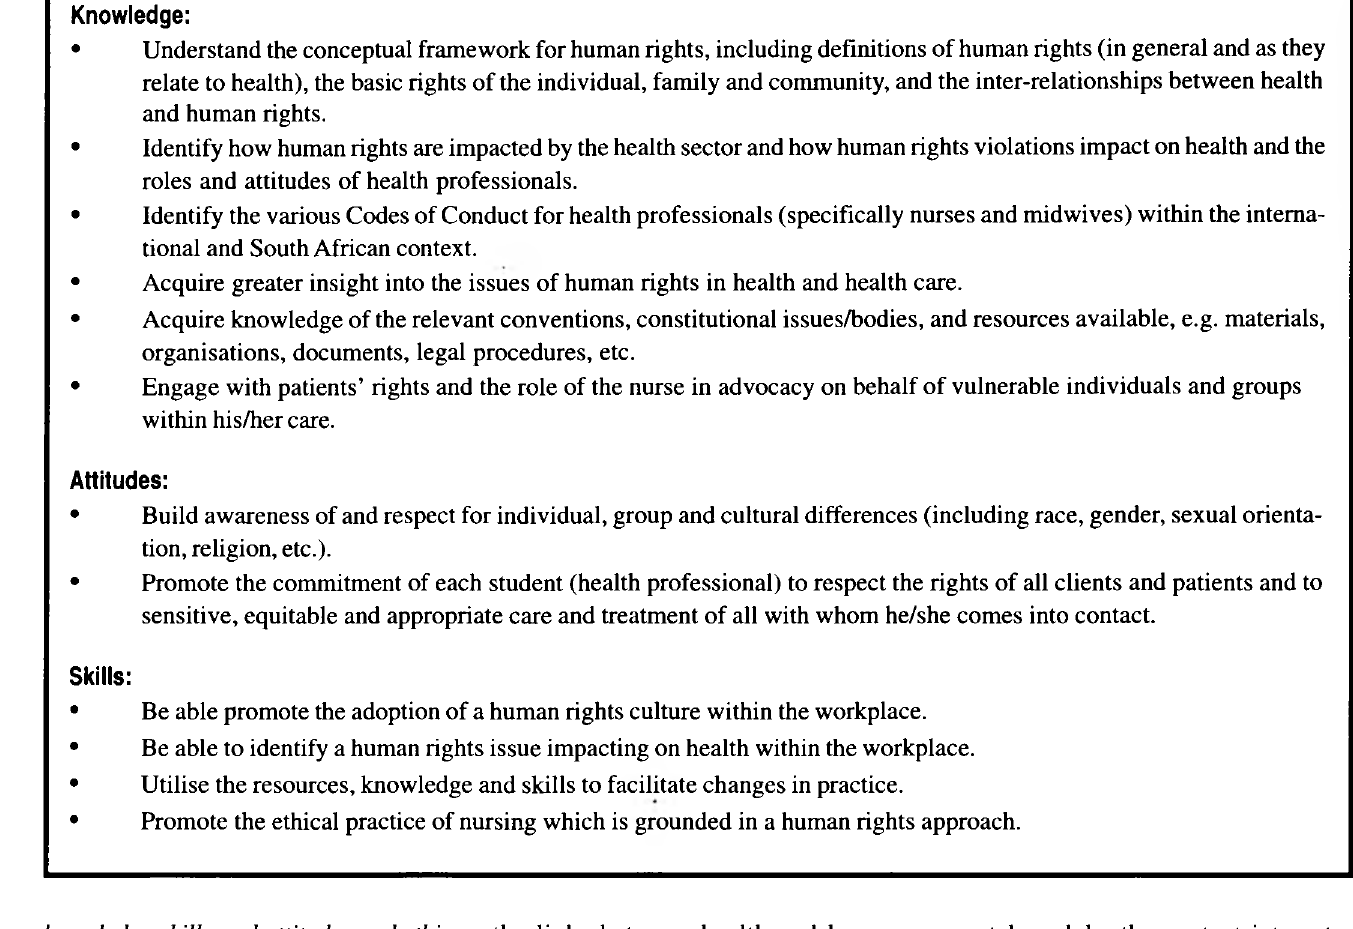
Table 1. Learning objectives for Health and Human Rights module.